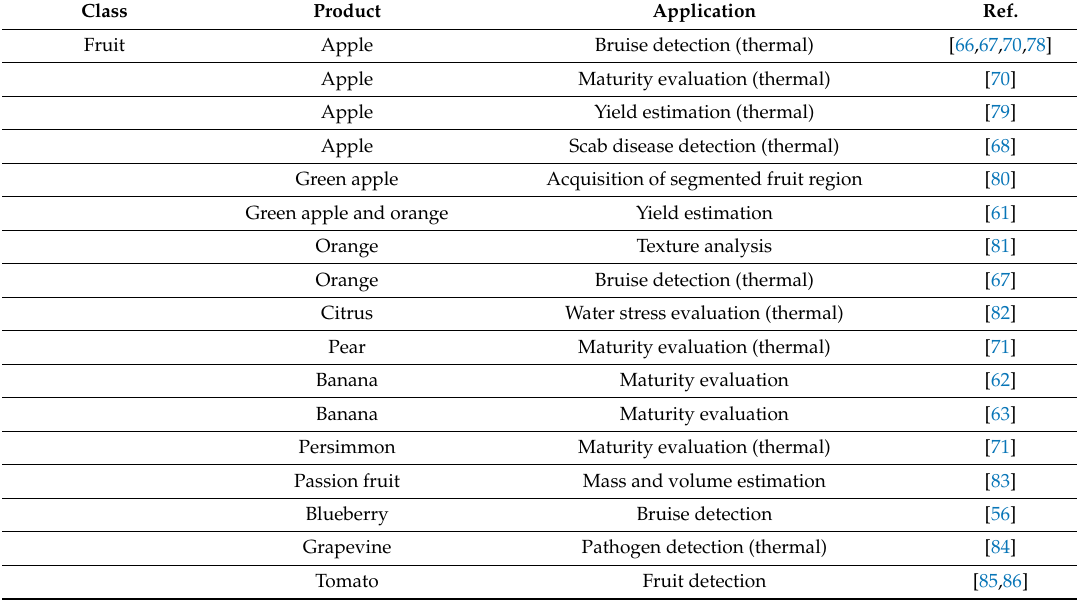
Table 5. Applications of imaging technique in